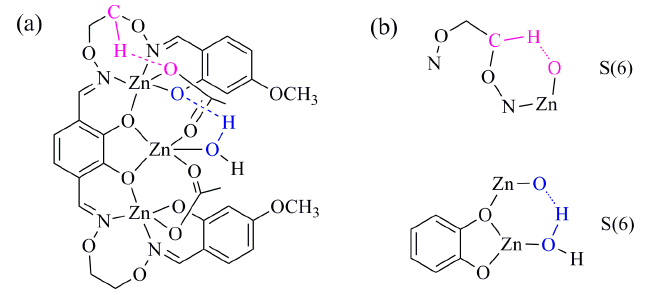
Figure 5. ( a ) Graph set assignments for the Zn II coordination compound; ( b ) Partial enlarged drawing of hydrogen bonds.